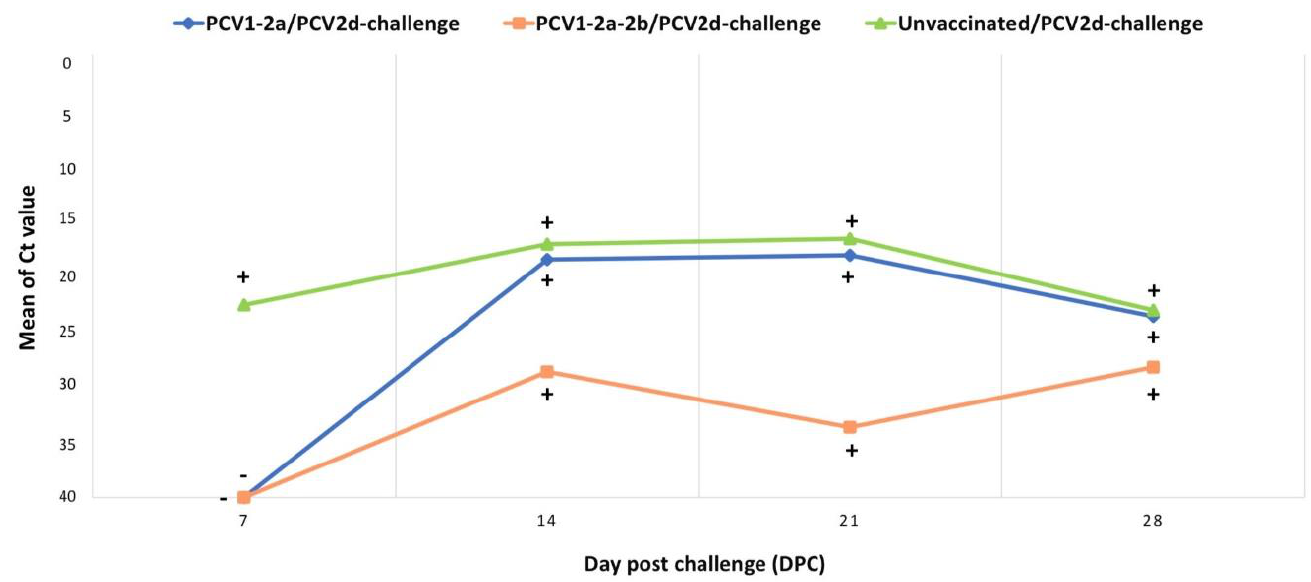
Figure 5. Determination of PCV2 viremia by real-time PCR. Mean Ct values indicated that pigs in the PCV1-2a-2b/PCV2d-challenge group had low levels of or no PCV2 viremia when compared with the other groups. At 7 DPC, no viremia was detected in pigs in either the PCV1-2a or the PCV1-2a-2b vaccinated groups.